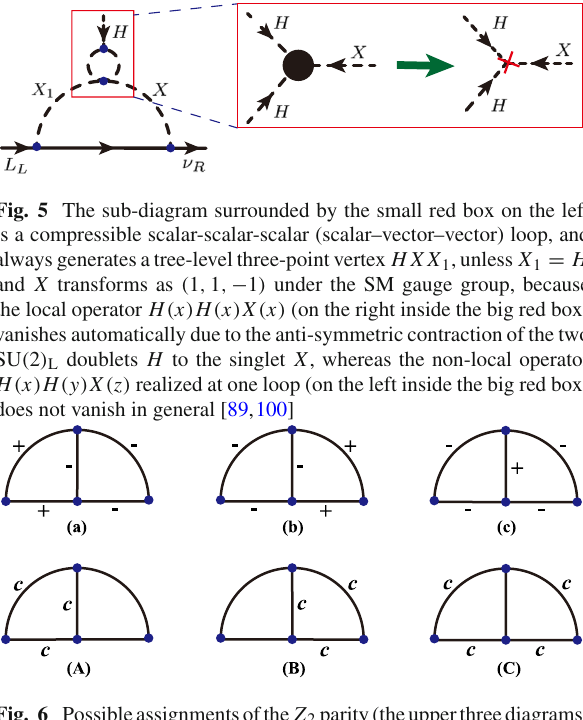
Fig. 6 Possibleassignmentsofthe Z 2 parity(theupperthreediagrams) and the color c (the lower three diagrams) to the internal fields of the structure diagram. Note that the diagrams with all their internal fields labeled with c or + have been eliminated, because no place is left for the DM candidates in this